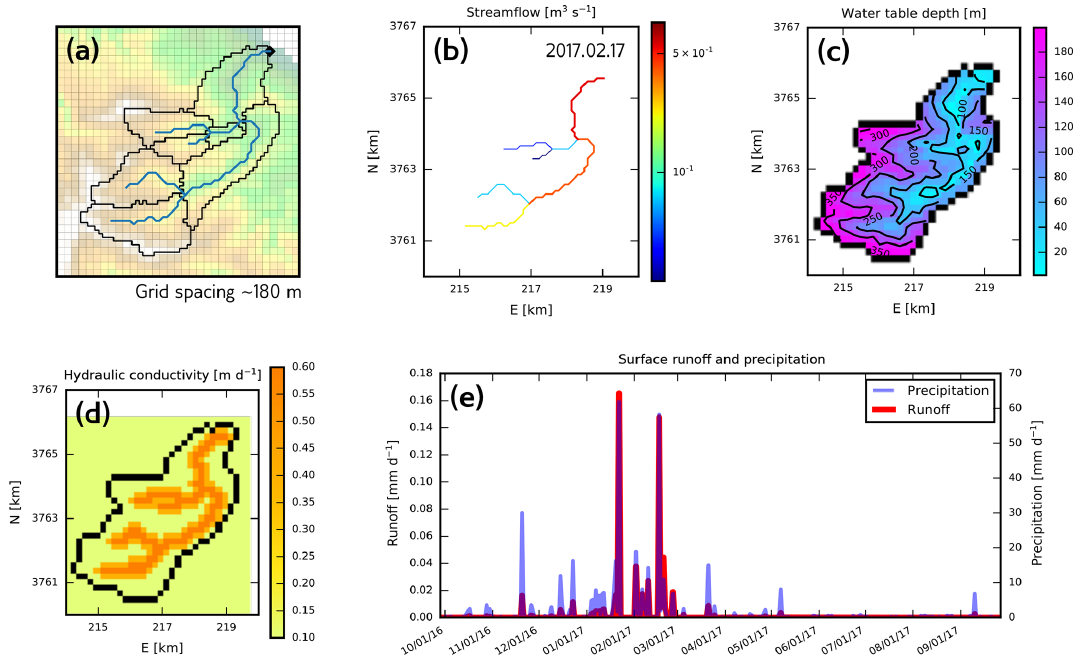
Figure 8. Model based on Water Canyon, Santa Rosa Island, California, USA. (a) Map with MODFLOW grid, HRU outlines, stream segments (blue), and digital elevation model. (b) Streamflow accumulation through the drainage network. (c) The modeled water table distribution with elevation contours (ma.s.l.). (d) Spatially variable hydraulic conductivity structure, with hydraulic conductivity increasing near the channel to represent alluvium and colluvium. (e) Simulated surface runoff contributions to catchment-wide discharge compared with